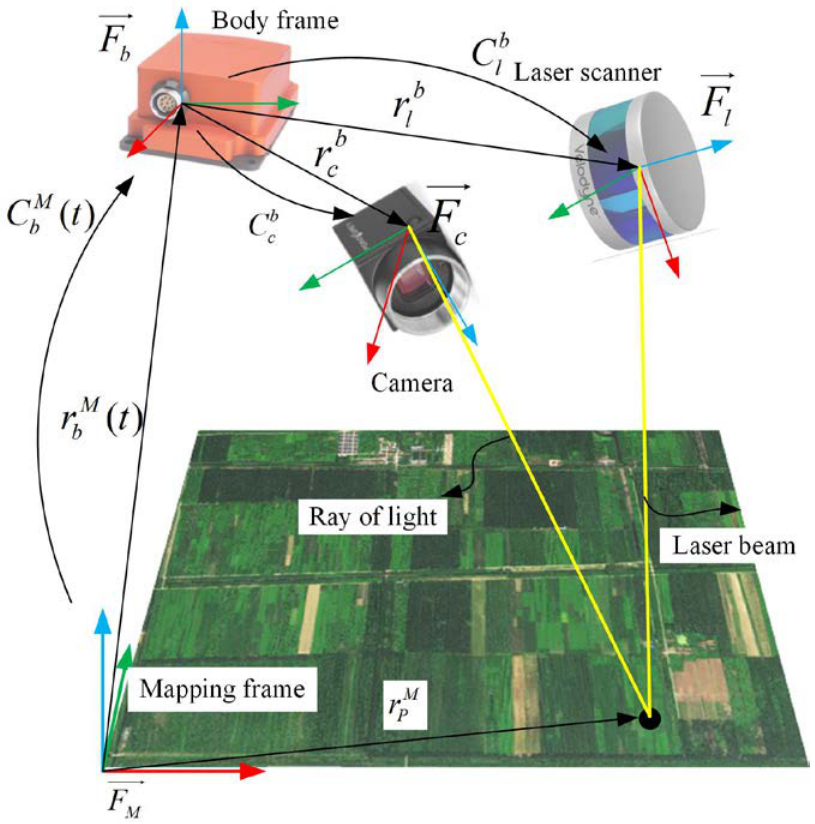
Figure 5. Coordinate definitions of the proposed data integration.